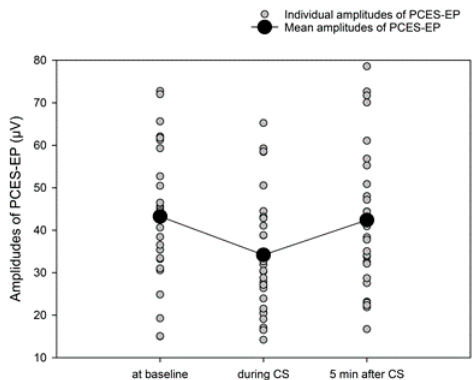
Figure 6. Amplitudes of cortical potentials evoked by PCES-EP at baseline, during CS and five minutes later.